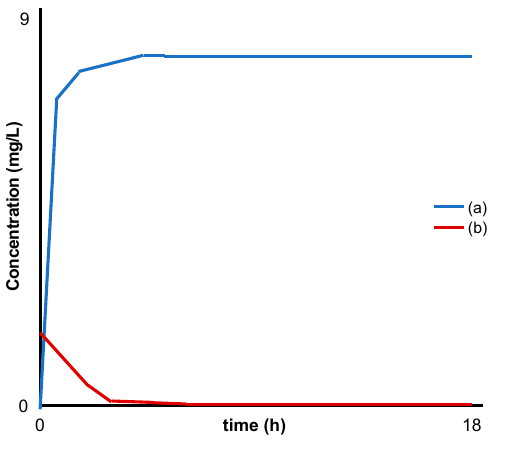
Figure 3. Modified schematic from Yokogawa et al. [29] representing: ( a ) release of fluoride and ( b ) absorption of sulfur compounds (H 2 S water) by MgFe LDH.